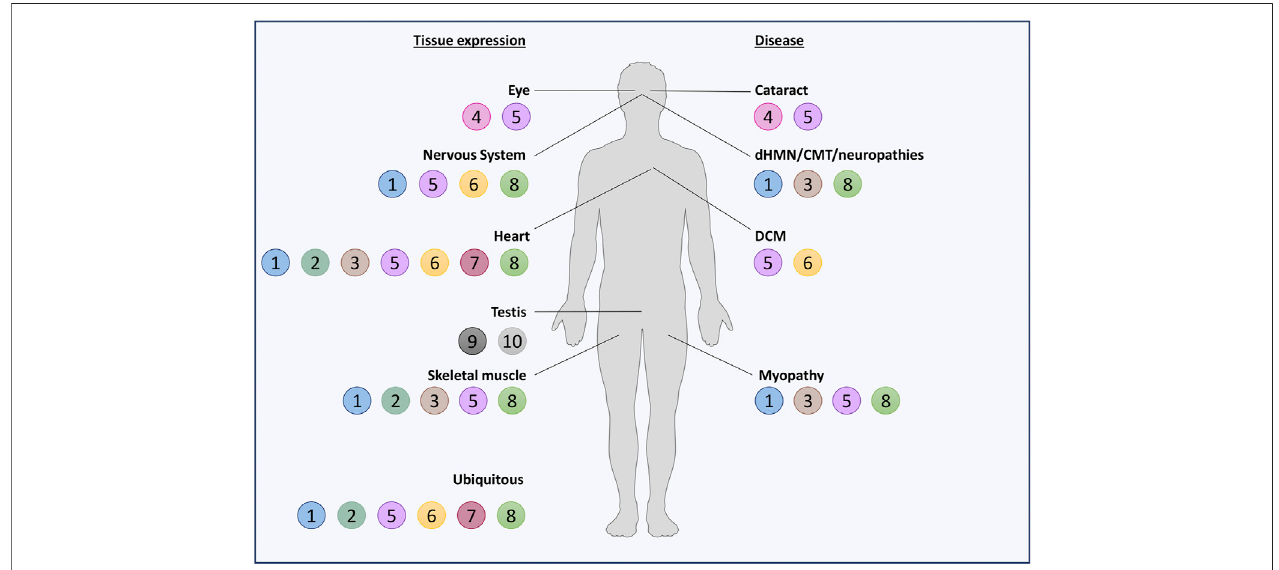
FIGURE 2 | Schematic representation of HSPBs tissue expression and related diseases. HSPBs are represented as beads and numbered based on HUGO nomenclature. On the left, HSPBs tissue expression is reported: most of HSPBs are expressed ubiquitously, but predominantly in certain tissues; other HSPBs show a tissue-speci fi cexpression.Ontheright,diseasesinwhichHSPBsmutationshavebeenidenti fi